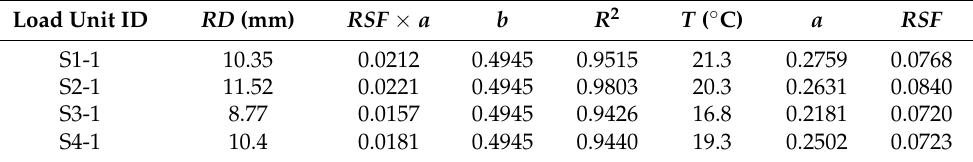
Table 3. Initial calibration results of the rut depth prediction model coefficients, based on the test results in the initial load units.